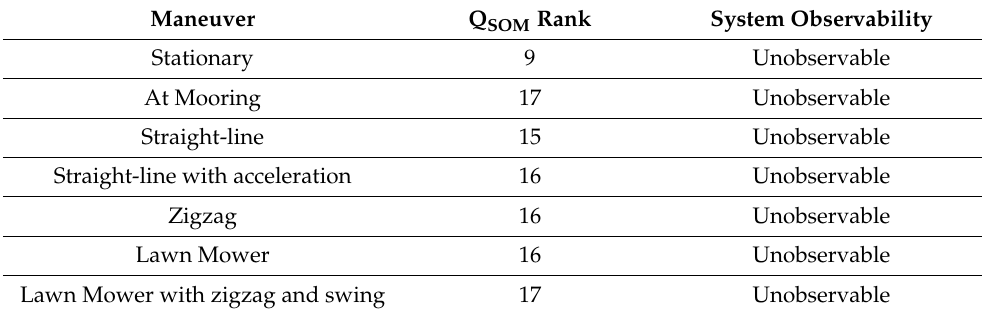
Table 3. Observability and final rank of Q SOM ( j = 100). INS/DVL integration.